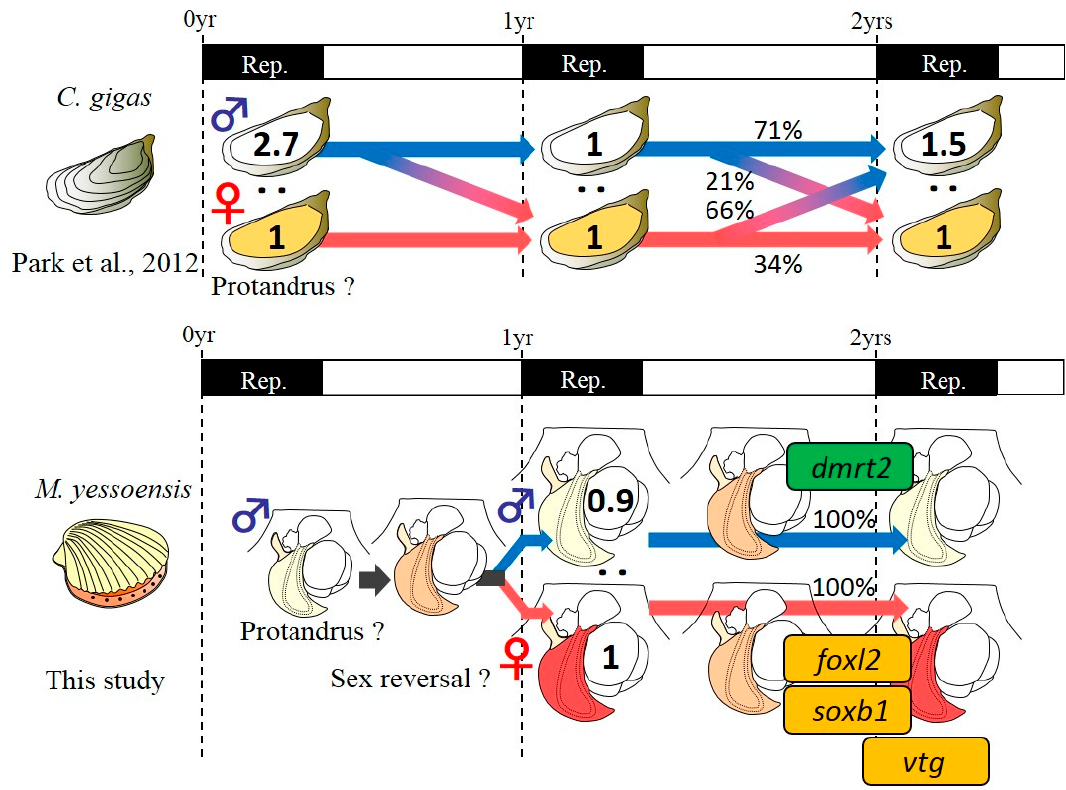
Figure 8. Scheme of phenotypic plasticity of sex in two bivalve species from tracking studies and expression of sex identification markers. Pacific oyster Crassostrea gigas exhibits an alternative sexuality [7] while the Yesso scallop Mizuhopecten yessoensis shows a sex-stable sexual maturation from one to two years of age. In the scallop, for male differentiation, my-dmrt2 is dominantly expressed in the male gonads. In contrast, for female differentiation, my-foxl2 , my-soxb1 , and my-vtg are consistently expressed at a higher level in the female gonads.